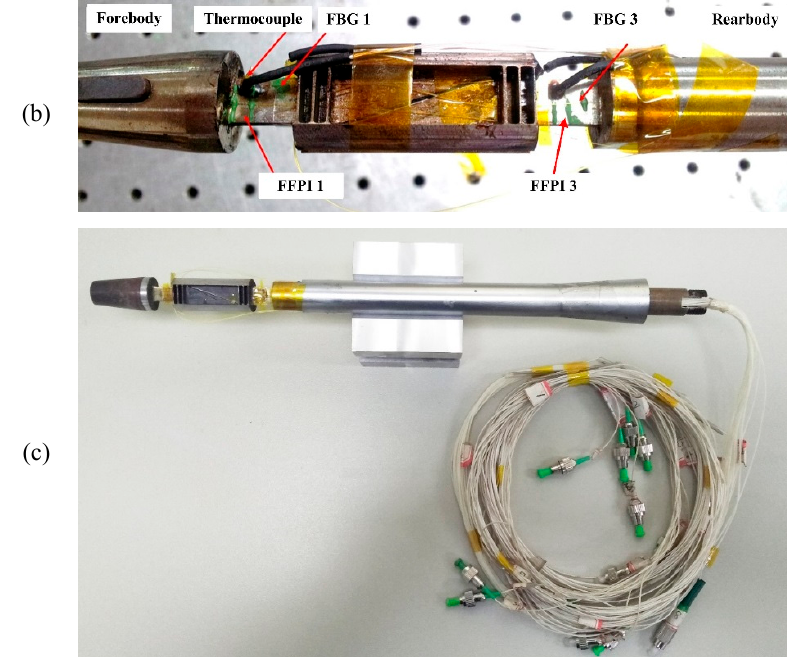
Figure 9. Force balance mounted with eight FFPI strain gauges and four fiber Bragg grating (FBG) temperature sensors: ( a ) design scheme, and ( b ) detailed and ( c ) overall photos of the balance.